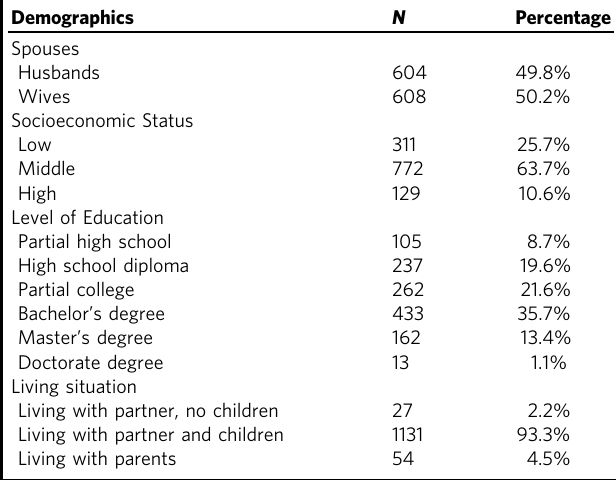
Table 2 Participant demographic